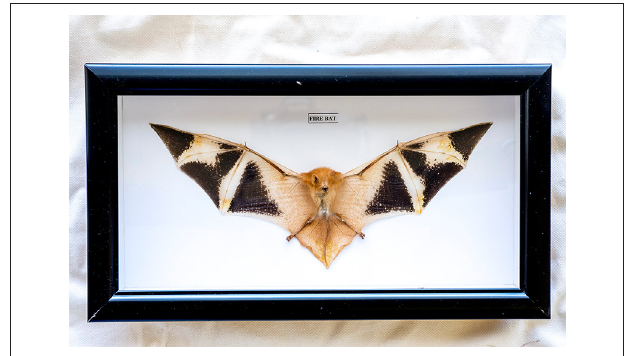
FIGURE 1 | Picture of a “Fire bat” preserved in a wooden box sold on Ebay.